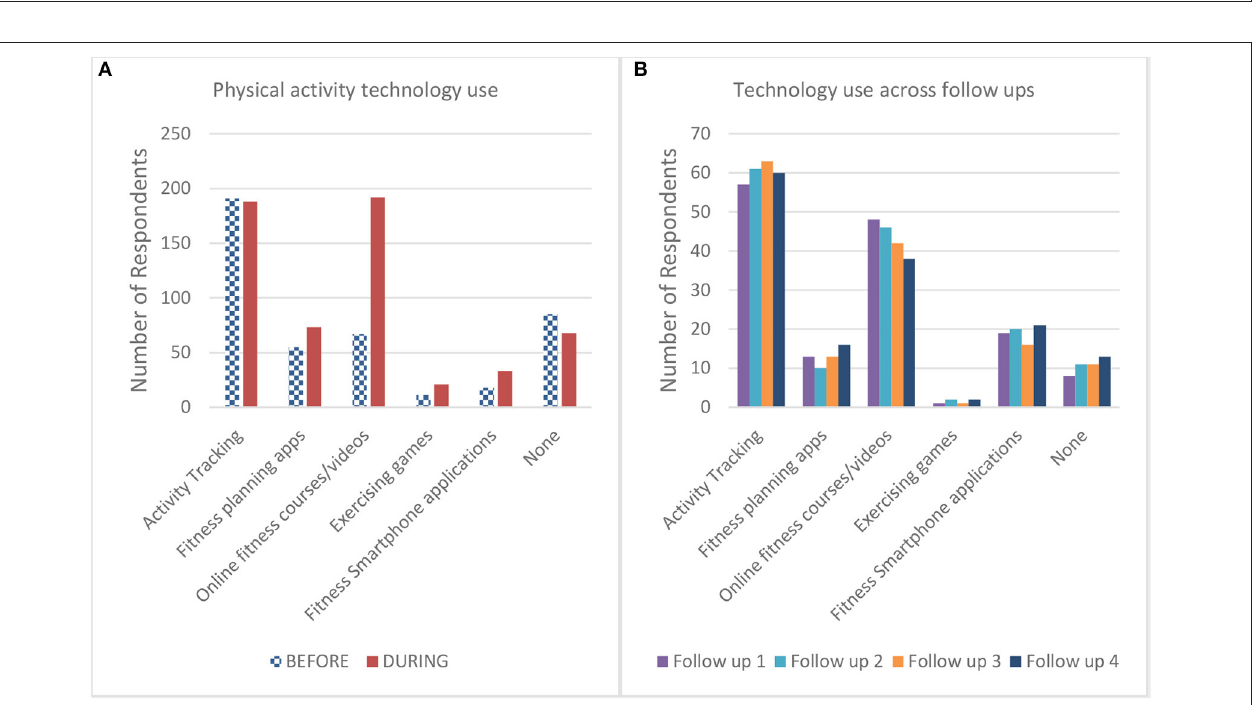
FIGURE 1 | The reported minutes of exercise across the follow up